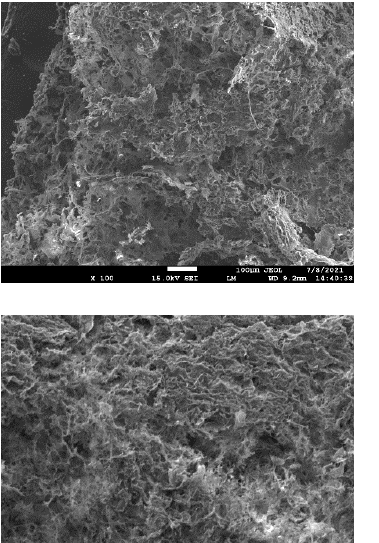
Figure 8. ( a ) Thermogravimetric analysis of PVA and PVA/CNF/CHL composites. ( b ) dTG analysis of PVA and PVA/CNF/CHL composites.